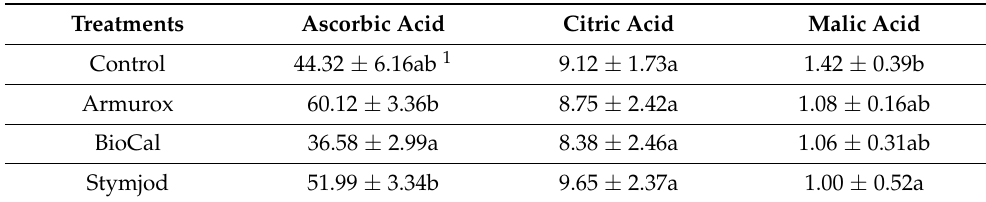
Table 9. Effect of foliar fertilization on organic acids content (mg 100 g − 1 ) of highbush blueberry fruits in